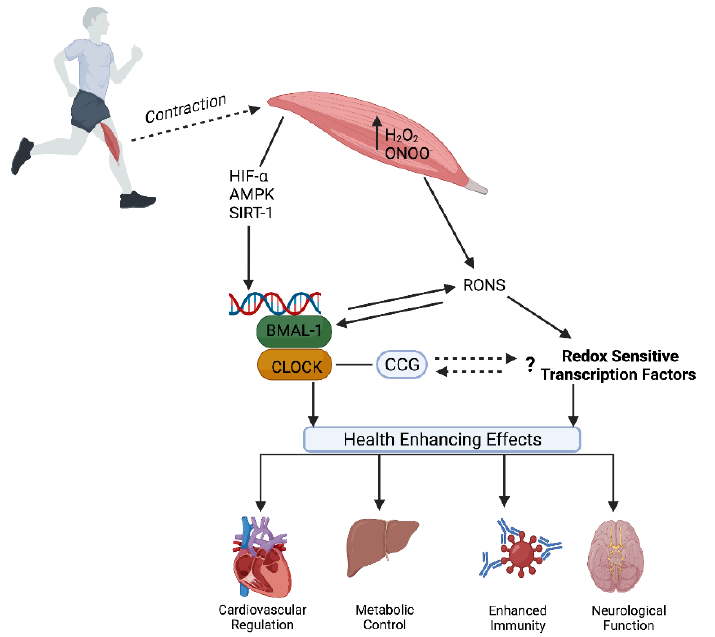
Figure 4. The interplay between Circadian and Redox Biology: Exercise as a zeitgeber and source of RONS. Exercise is a potent stimulus to entrain dysregulated circadian systems and positively affect the core molecular clock and subsequent expression of CCGs throughout the body. At the same time, exercise-induced RONS are integral to several recognised physiological responses and adaptations via the activation of redox-sensitive transcription factors (e.g., up-regulation of immunity, antioxidant enzymatic activity, etc.). It is possible that both circadian and redox signalling are inter-connected and operate synergistically to confer protective health effects following regular exercise.